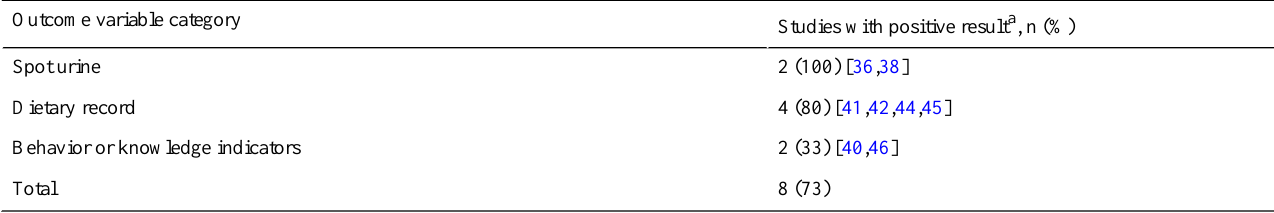
Table 4. Summary of effectiveness results (among the 11 randomized controlled trials and quasi-experimental